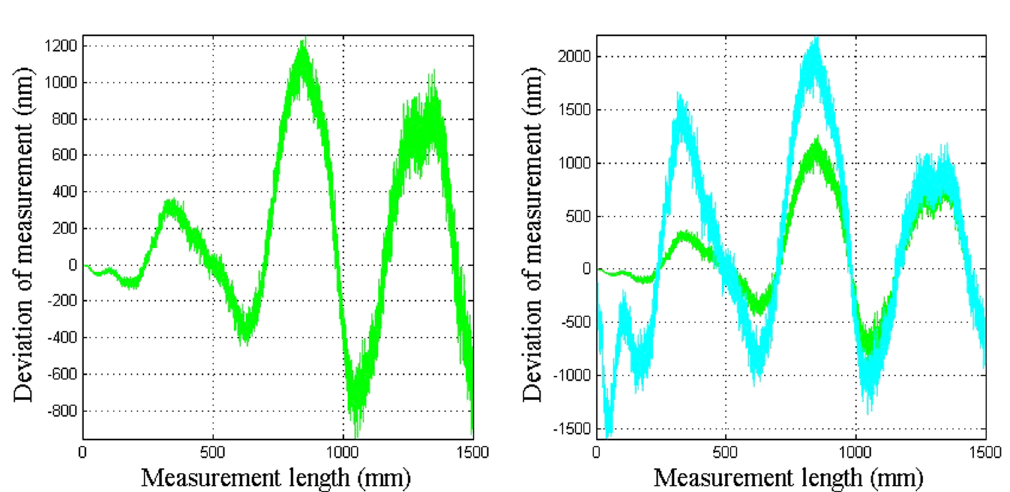
Figure 5. The deviation caused by the uncertainty in each optical distance measurement using the two-color method: ( a ) the deviation of the measurement arm; ( b ) comparison of the deviation in the measurement arm and the correction